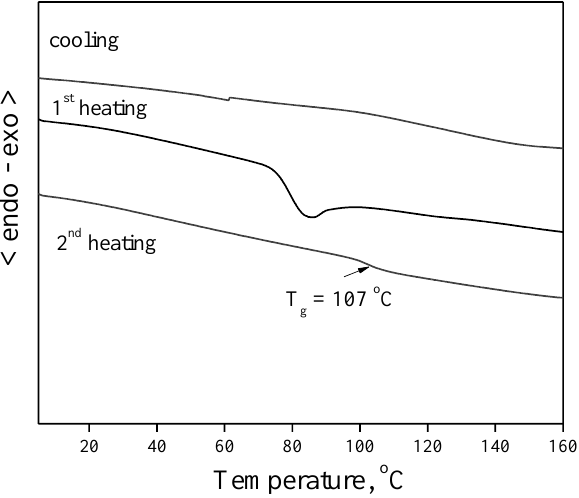
Figure 1. Thermo-gravimetric analysis curve of material 4 . DSC measurements have confirmed that the synthesized derivative 5 is fully amor- phous material with clearly expressed high glass transition temperature (T g ). Results of the measurement are presented in Figure 2. The curve of the second heating of the DSC characterization, which shows the most exact T g of the material, demonstrates a value of 107 °C. No peaks due to melting or crystallization were obtained during all the measure- ments; i.e., the material is fully amorphous and well suitable for preparation of thin ho- mogeneous layers.